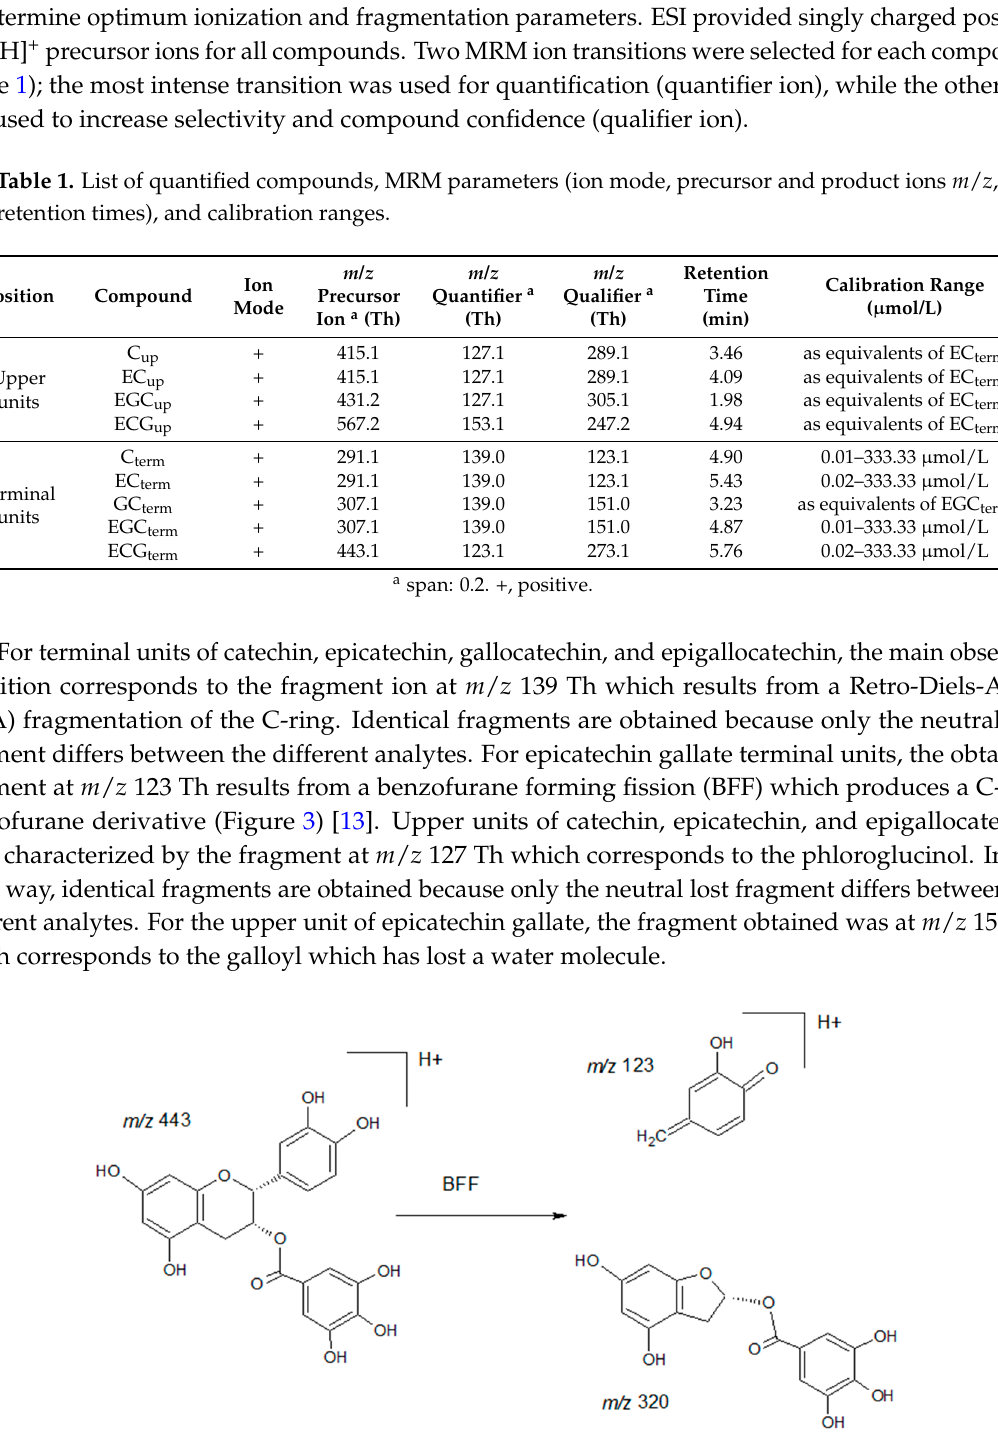
Figure 3. Fragmentation scheme for epicatechin gallate terminal unit in positive ionization mode. The fragmentation pathway involving benzofuran-forming fission (BFF) is demonstrated.